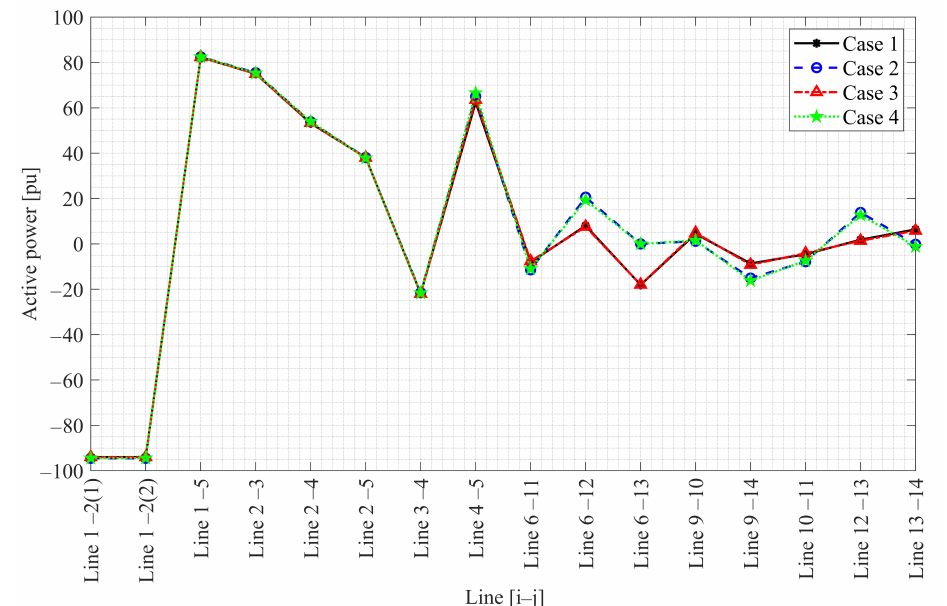
Figure 9. Active power flow in the 14-bus bar IEEE